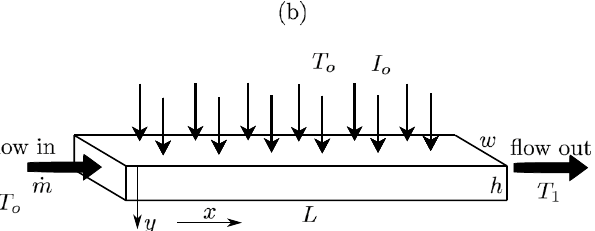
Figure 12. Theoretical analysis of a DASC (the figure was created using Inkscape version